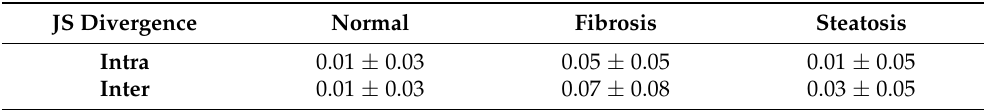
Table 2. Mean and standard deviation of intra- and inter-case JS divergence values for the three pathology